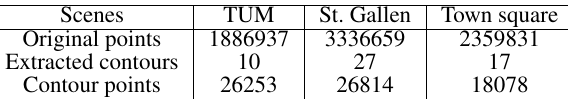
Table 3. Number of contour